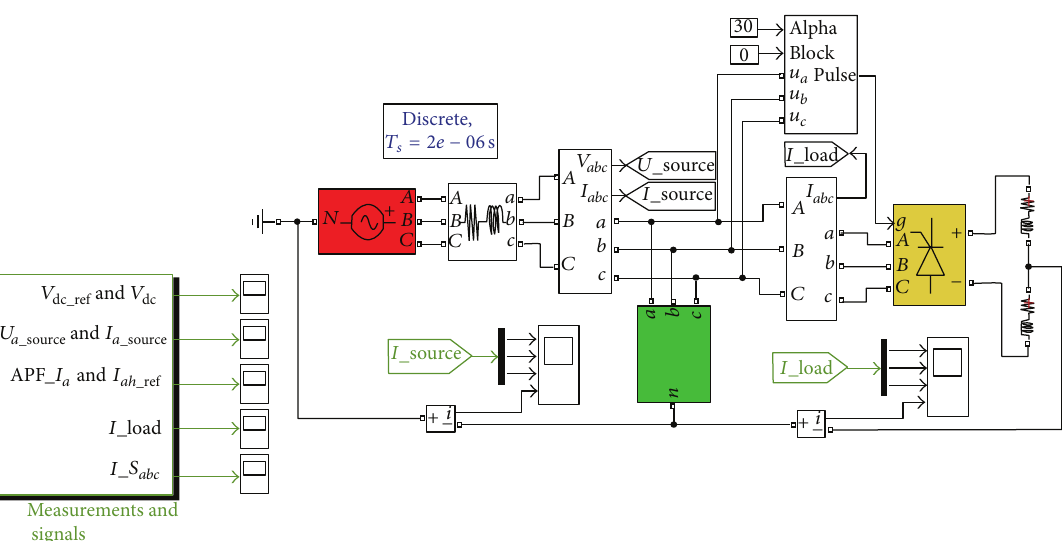
Figure 6: The diagram of the control of the 𝑁 leg based on triangle modulation strategy.